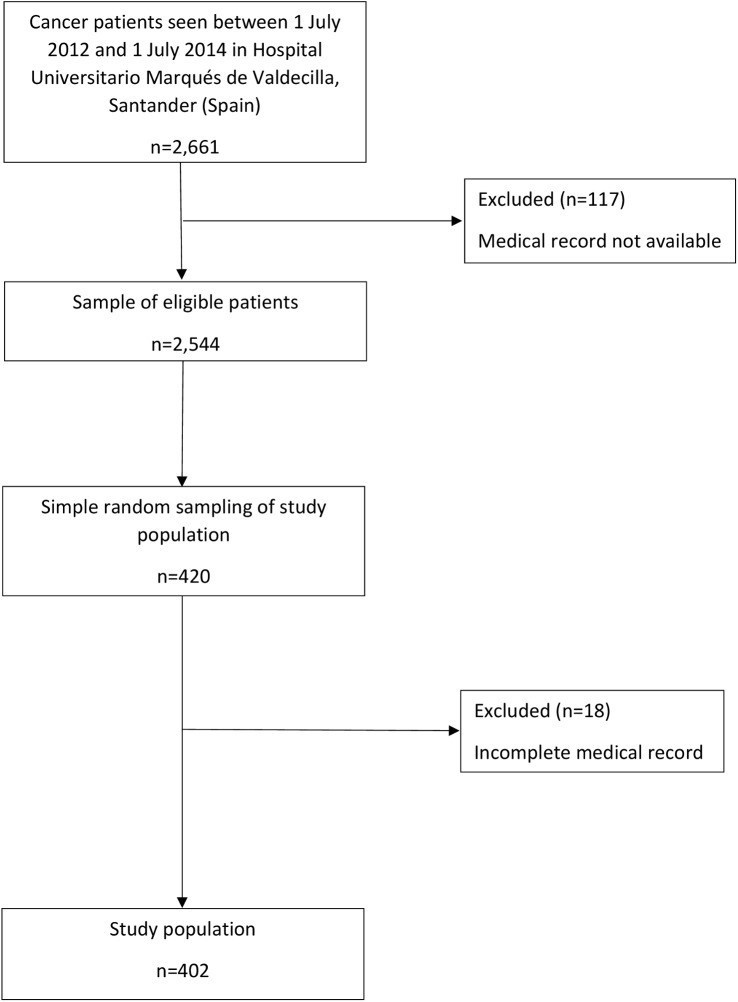
Overall study flow.